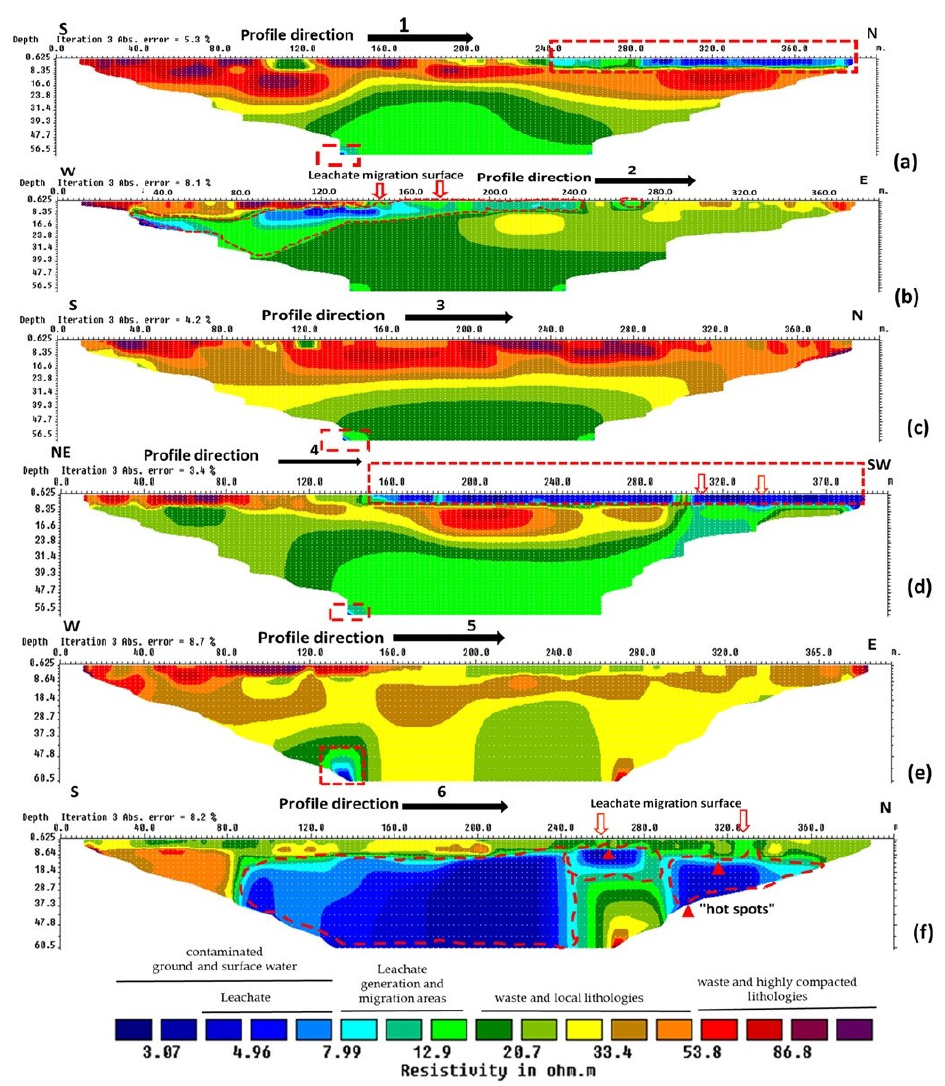
Figure 5. Profiles of the variation of the electrical resistivity in the study